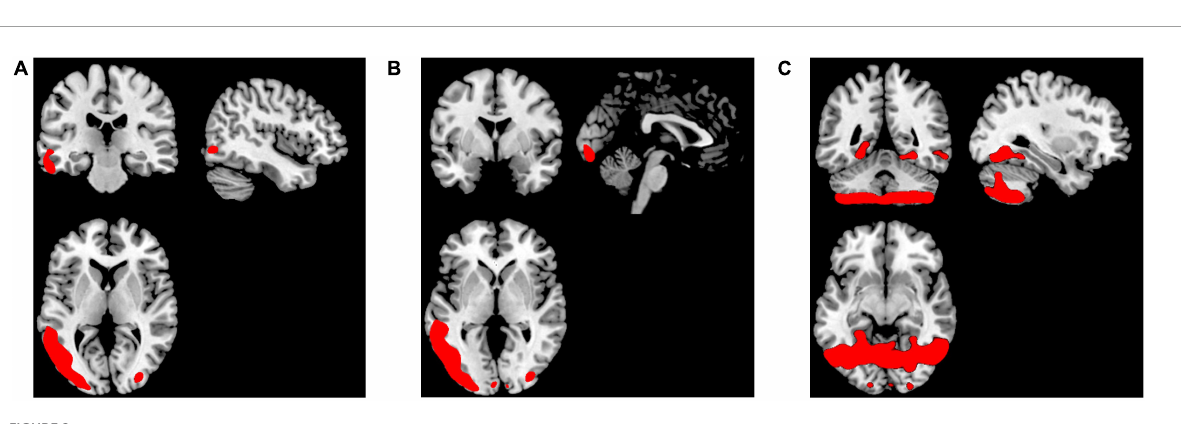
from the three types of groups that were described above. CWT was used to decompose the lambda series into their frequency components and the statistical features of the CWT coefficients were computed in the spatial domain. A CWT with a complex Morlet as mother function was used, see Figure 3 . The WT of a 1-dimensional (1D) series has two dimensions. This 2- dimensional (2D) output of the WT provides the spatial-scale representation of the original series in the form of a “scalogram” plane. The two dimensions of a scalogram are the geometrical points and the scales. Each value (wavelet coefficient) in the scalogram plane represents the correlation of the lambda series with the Morlet wavelet on the respective point and scale